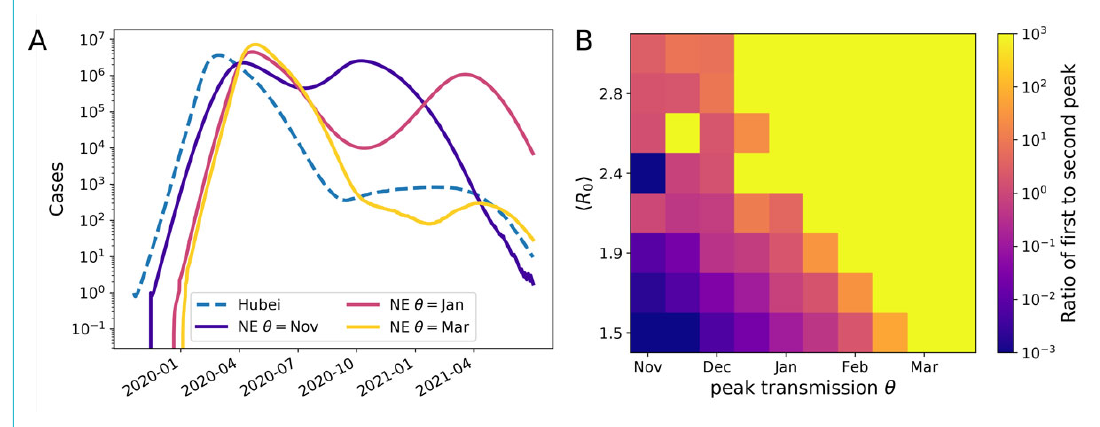
Figure 3: Model predictions for SARS-CoV-2 case numbers in temperate zones for a pandemic scenario. Panel A shows example trajectories assuming SARS-CoV-2 transmissibility peaks in November, January, or March. These outbreaks in Northern Europe (‘NE’) are assumed to be seeded by the outbreak in Hubei (model trajectory shown as a dashed line). Within the model, these cases are exported at rate of 0.01/year to temperate Northern Europe with an average ‹R 0 › = 2.2 and seasonal forcing of ε = 0.5. Corresponding graphs for different values of (R 0 ) and the migration rate are shown in supplementary figure S4. Panel B shows the ratio of the first and second peak for a range of different combina- tions of R 0 and θ. The yellow area corresponds to parameter combinations with essentially only an early peak similar to the yellow line on the left. The blue/purple area shows parameter combinations for which a peak in late 2020 dominates, as with the purple line on the left, while the central pink/orange band shows the combinations giving rise to two comparable peaks. These simulations are for ε = 0.5. Similar results were obtained for ε = 0.3 and 0.7, see figure S6 (appendix